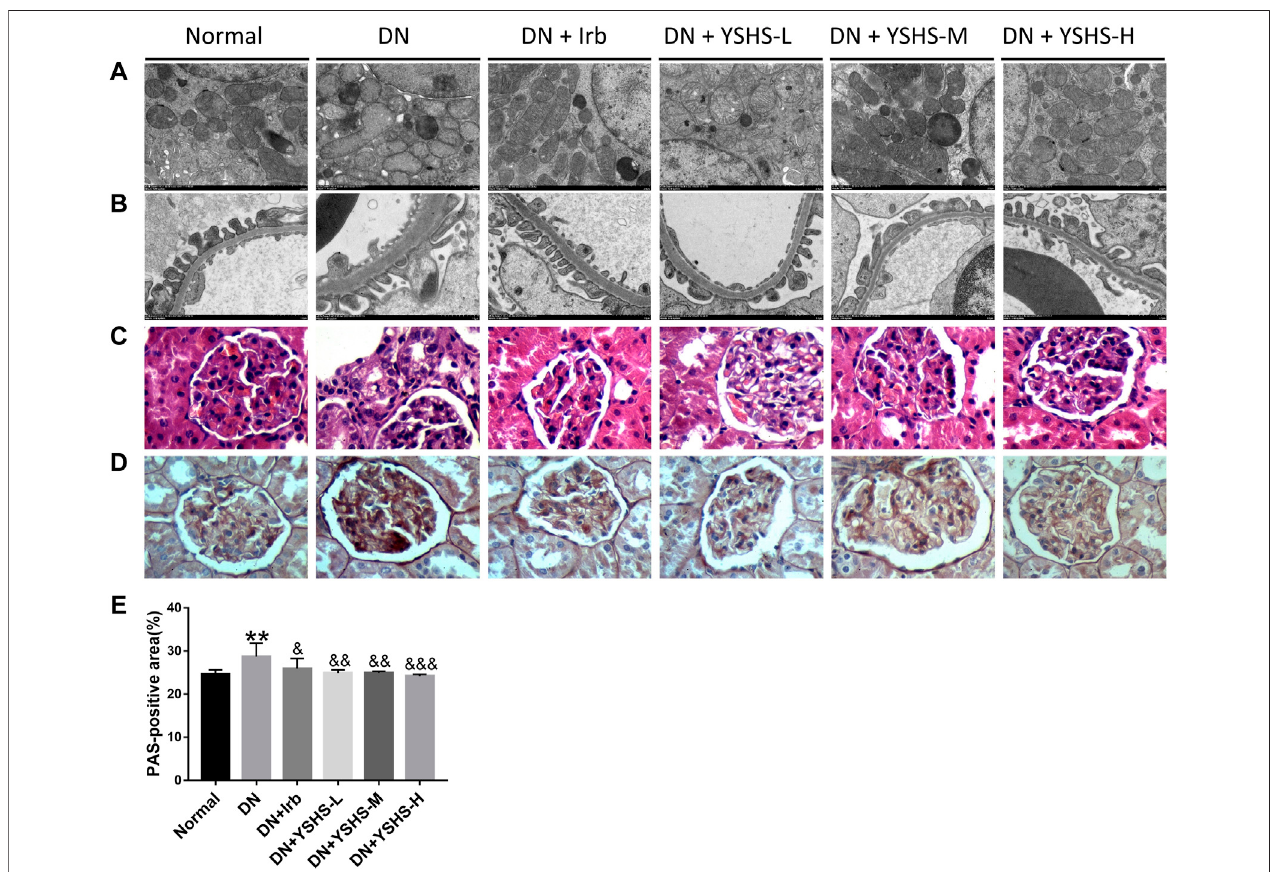
FIGURE3| EffectsofYSHSonhistopathologicchangesofDNrats.TEM (A,B) ,H&E (C) ,andPAS (D) stainingofYSHSindifferentgroupsonDN. (E) PAS-positive area was analyzed by the IPP software. Values are presented as means ± SEM. ** p < 0.01, vs. Normal; & p < 0.05, && p < 0.01, &&& p < 0.001, vs. DN.